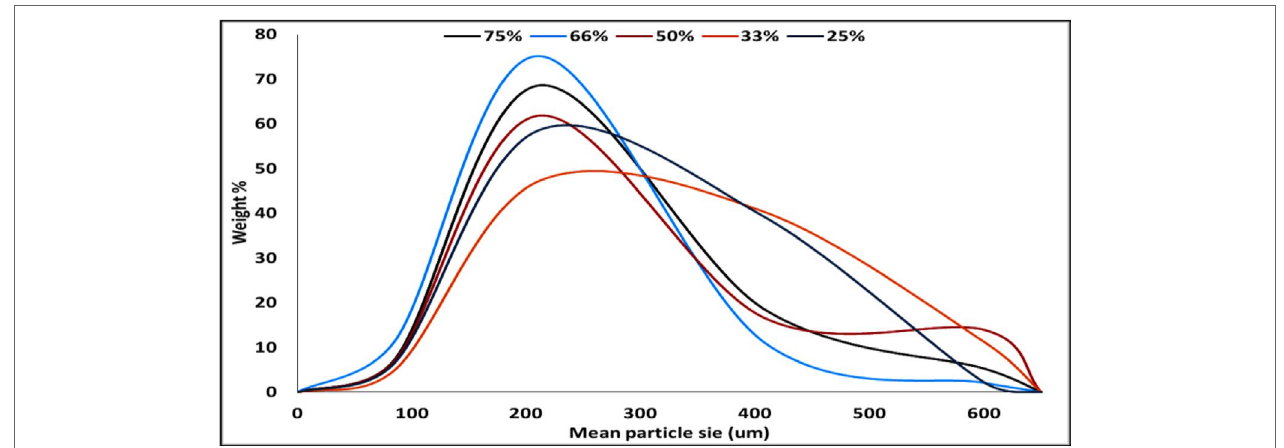
FIGURE 4 | Particle size distribution of Span 60-encapsulated drug prepared by using different. Different TDC.